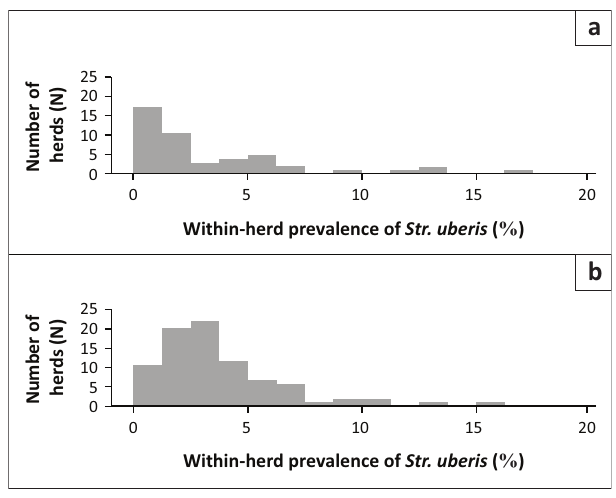
FIGURE 1: Distribution of the within-herd prevalence ( % ) of Streptococcus uberis in (a) 2008 and (b) 2013.